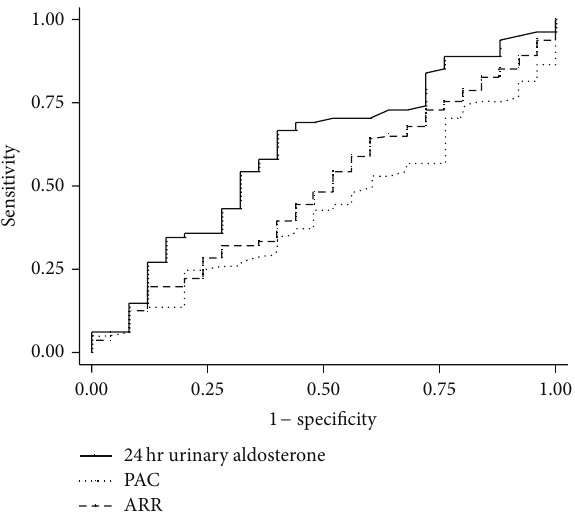
Figure 1: ROC curve: to predict the presence of LVH in patients with primary aldosteronism: the ROC AUC of log-transformed 24 hr urinary aldosterone is larger than that of PAC or ARR. (ROC AUC for log-transformed urine aldosterone: 0.701 (95% CI 0.601– 0.801), for PAC: 0.568 † (95% CI 0.456–0.68), for plasma aldosterone to renin activity ratio: 0.56 ¶ (0.445–0.675), † 𝑃 < 0.01 ¶ 𝑃 < 0.05 , compared with log-transformed urine aldosterone).